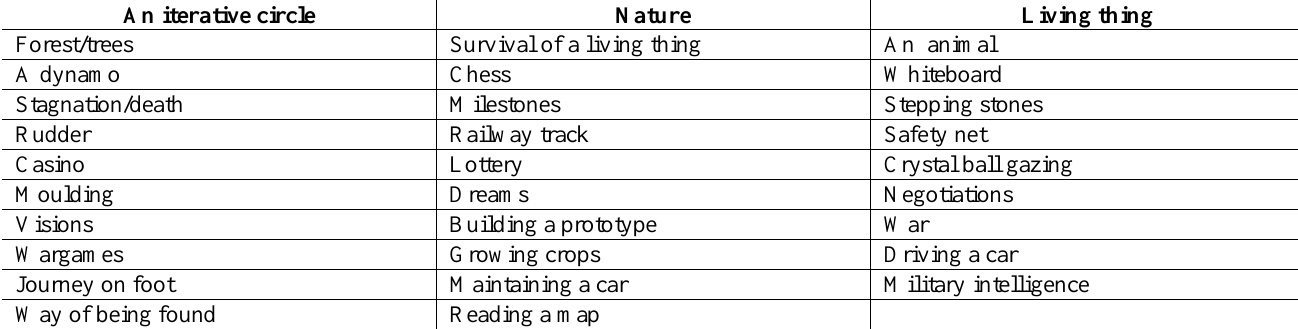
Table 3: List of metaphors by interviewees An iterative